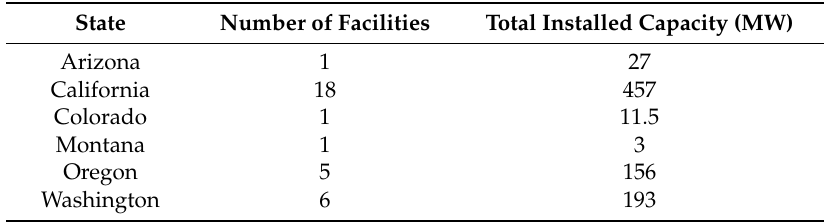
Table 2. Electric generating facilities in western states using woody biomass